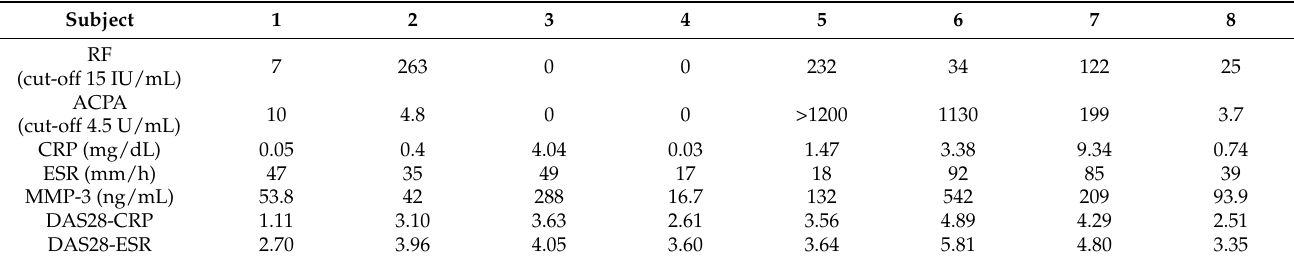
Table 2. Laboratory